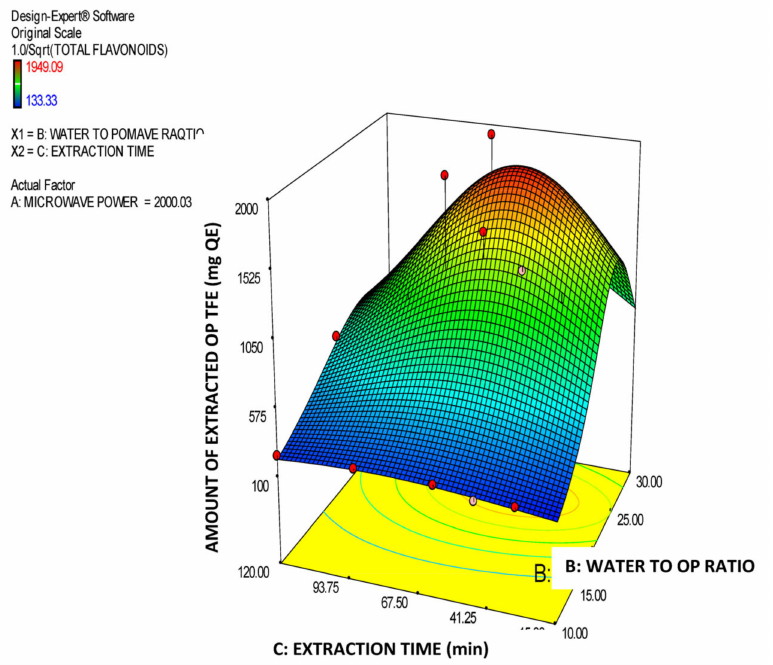
Figure 8. Response surface plot of the amount of extracted total OP flavonoids (TFE in mg QE) for the B × C interaction (B: Water to orange pomace ratio; C: Extraction time